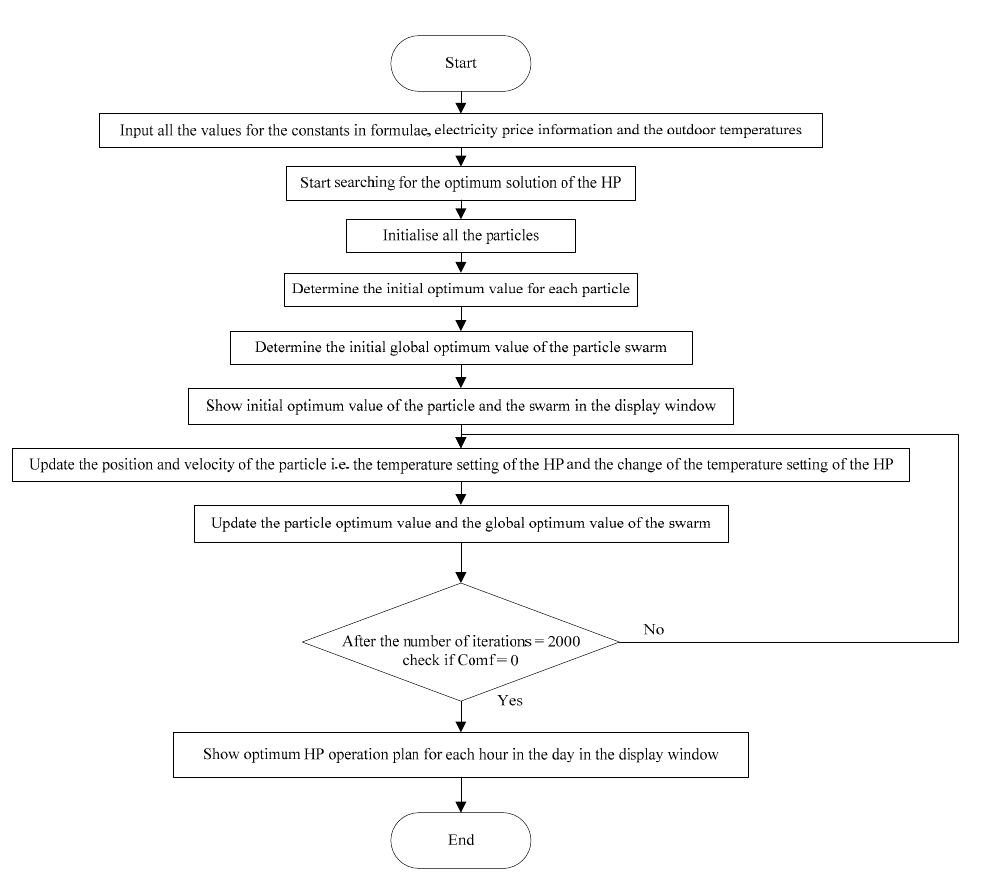
Figure 4. Flowchart of HP control program using PSO.